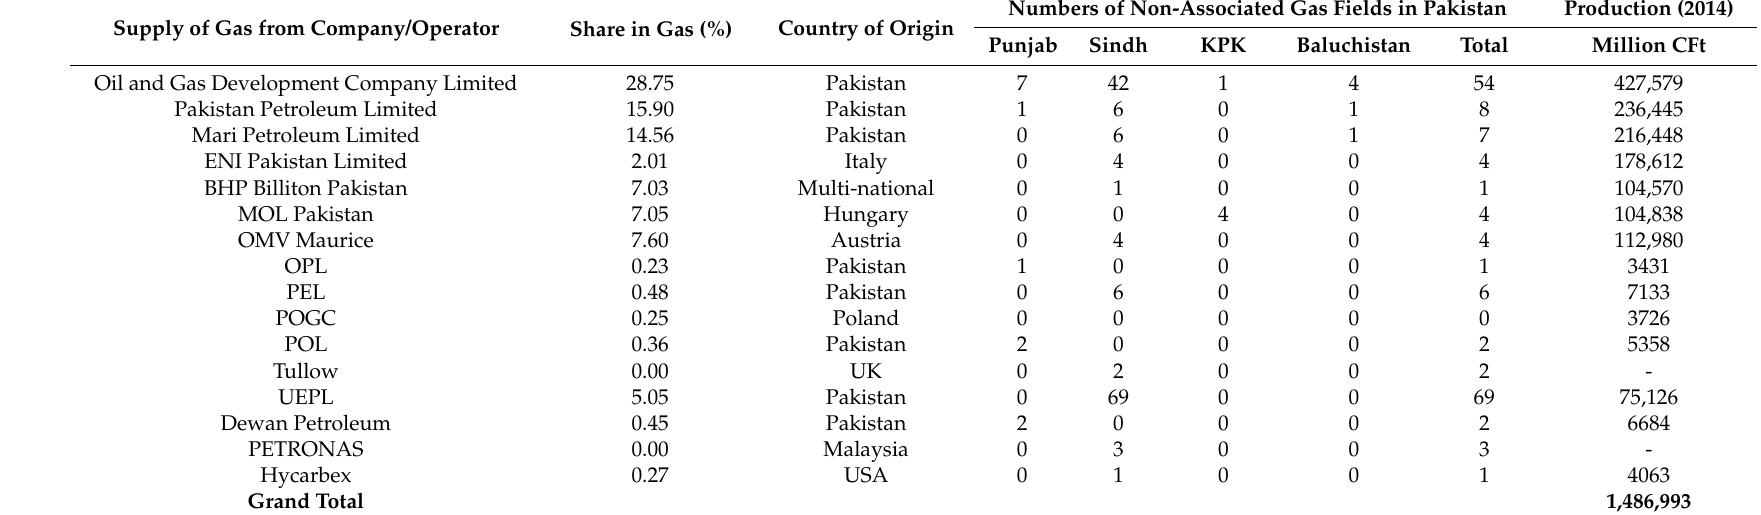
Table 2. Supply of gas from different companies in